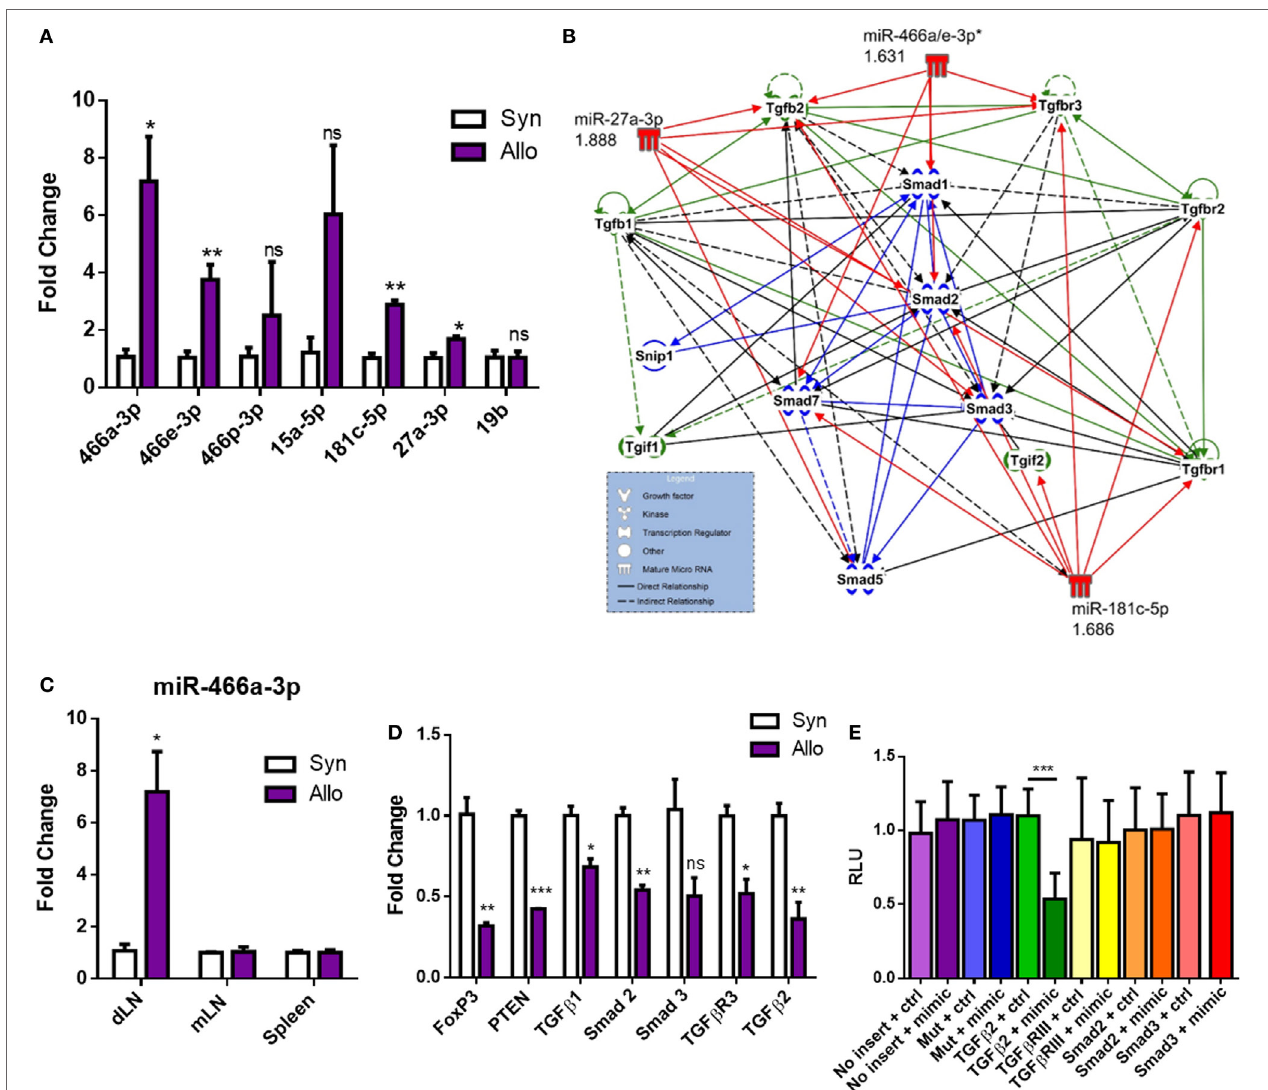
FigUre 2 | Alloantigen-induced microRNAs (miRNAs) target transforming growth factor-beta (TGF- β ) family members and signaling molecules. Total RNA was extracted from purified CD4 + cells in the draining lymph node (dLN) of syn- or allografted mice 10 days post transplant. (a) Validation of microarray results through quantitative real-time (qRT)-PCR. (B) Ingenuity Pathway Analysis of seven of the top upregulated miRNAs and their predicted targets. (c) Fold change miR-466a expression in the dLN, spleen, or mesenteric lymph node (mLN) of purified CD4 + cells derived from syn- or allografted mice. (D) qRT-PCR validation of mRNA expression changes in the dLN CD4 + cells of syn- or allografted mice; n = 8 (syngeneic) or 12 (allogeneic) mice per group. (e) Relative luciferase expression in EL-4 cells transfected with luciferase reporter constructs which contained 3' untranslated region (3 ′ UTR) of proteins of interest or a mutated 3'UTR, together with miR-466a-3p mimics or the negative scramble control. A total of 48 h after transfection, luciferase activity was detected. Normalized data were calculated as the quotient of Renilla/firefly luciferase activities and are presented as mean ± SEM of three independent experiments with two technical replicates indicating six measurements. * P < 0.05, ** P < 0.01, *** P < 0.005, **** P < 0.0001 by Student’s t- test